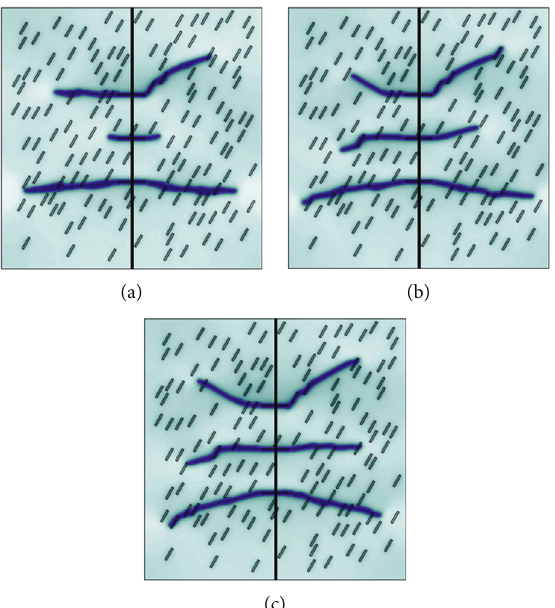
= 8m 2 /min , (b) Q = 9 : 6 m 2 /min , and (c) Q 0 0